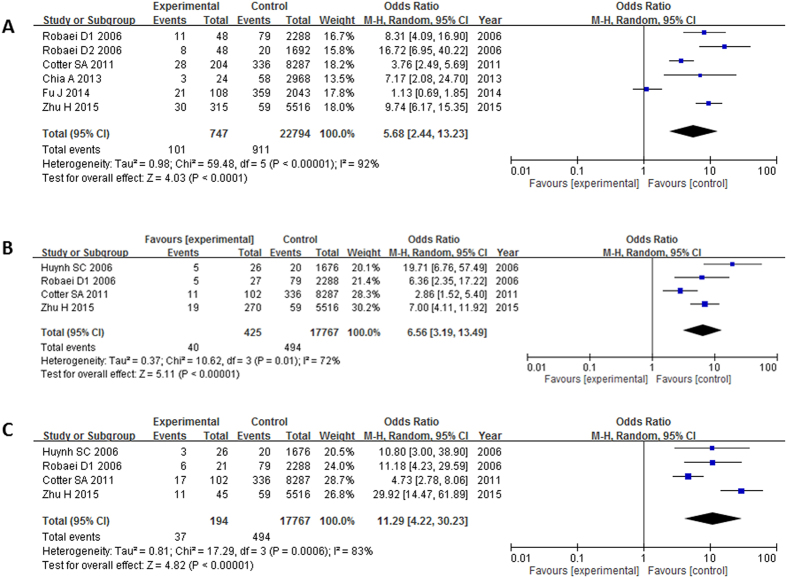
Meta-analysis of the association of anisometropia with different types of strabismus.The bars with squares in the middle represent 95% confidence intervals (95% CIs) and odds ratios (ORs). The central vertical solid line indicates the ORs for the null hypothesis. Diamond indicates summary OR with its corresponding 95% CI. (A) Association between anisometropia and strabismus. (B) Association between anisometropia and exotropia. (C) Association between anisometropia and esotropia.